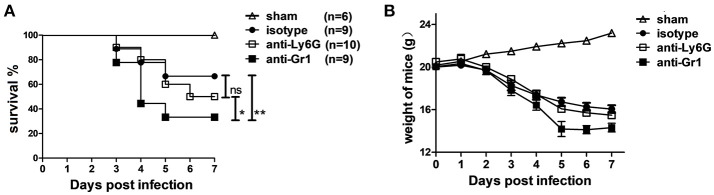
Depletion of Gr-1+ cells but not neutrophils increase susceptibility to CVB3 infection. Mice were treated with isotype, anti-Ly6G or anti-Gr-1 Abs on day −1 and 3 and subjected to 1500TCID50 CVB3 on day 0. The survival (A) and weight of mice (B) were monitored till 7 dpi. Sham mice with no viral infection were used as control. Results are presented as mean ± SEM; Data pooled from three independent experiments. *p < 0.05; **p < 0.01.